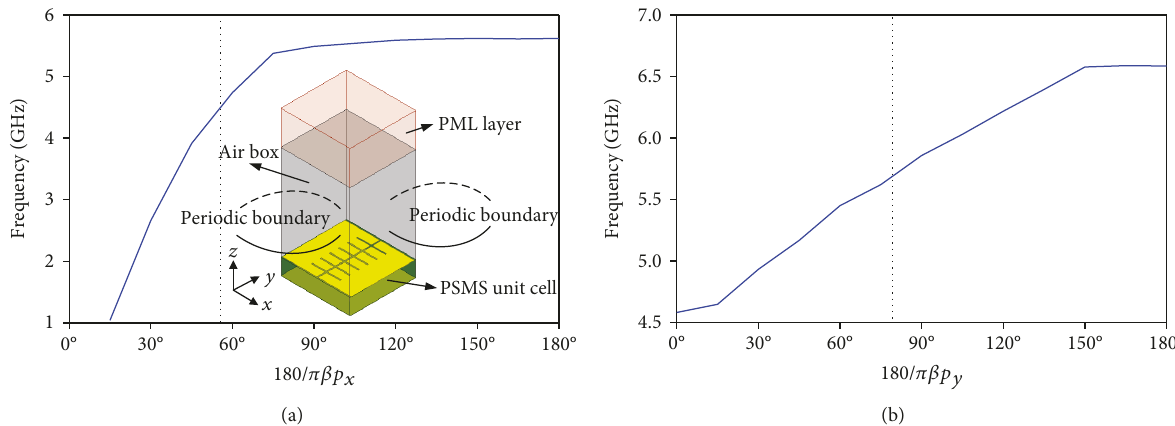
Figure 8: (a) HFSS simulation model of the PSMS unit cell and dispersion diagram in the x direction. (b) Dispersion diagram in the y